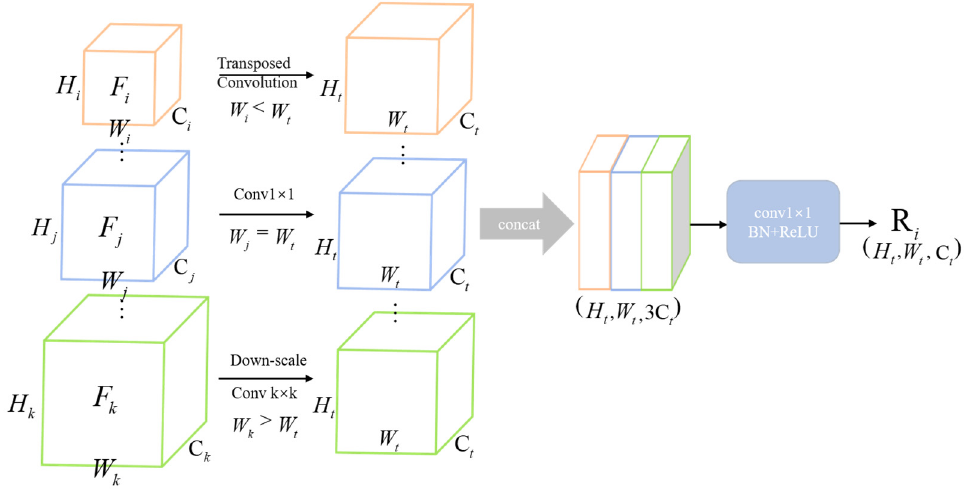
Figure 4. Details of PFFM module. The features obtained from MFEM are adjusted to the same di- mension as the target resolution by transposed convolution, conv operation, and down-scale. Then, feature cross-fusion maps at different stages are obtained using channel fusion and 1 × 1 convolu-